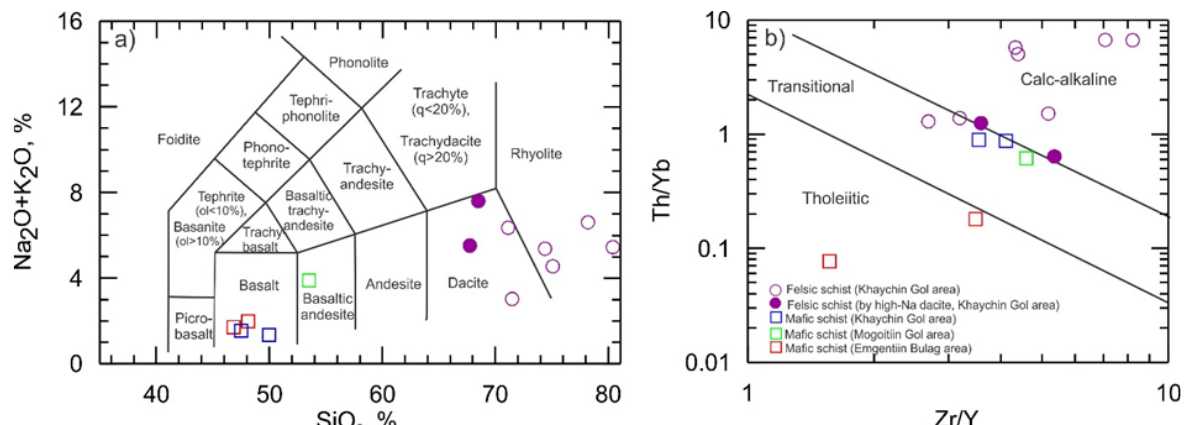
Fig. 8. Classification diagrams of the mafic and felsic schists from the Mogoittin Gol, Khaychin Gol and Emgentiin Bulag areas. a) SiO2 vs. (Na discrimination diagram (Ross and Bédard, 2009)